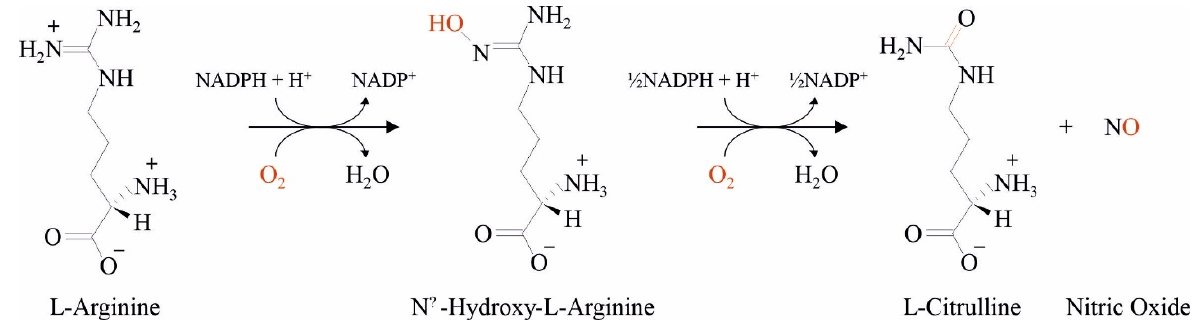
Figure 6. Biochemical reaction describing the catalytic activity of NOS in NO formation. The reaction consumes 1·5 mol of NADPH and 2 mol of oxygen.